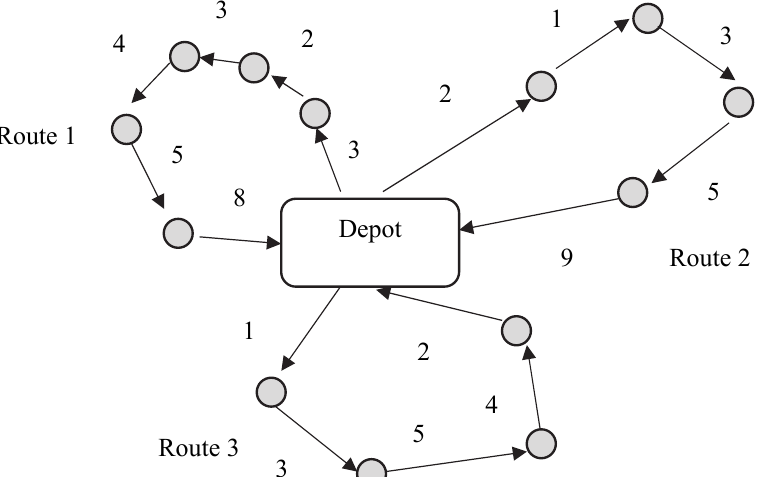
Fig.1. Routes routing for CVRP with a single central depot of the vehicle